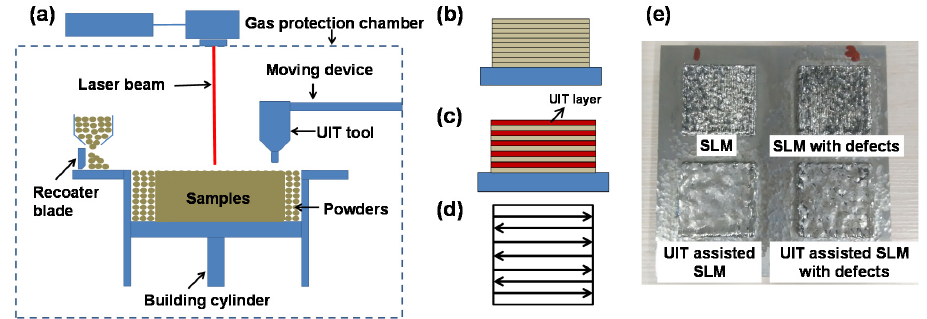
Figure 2. Schematic view of ( a ) UIT assisted selective laser melting (SLM); ( b ) SLM sample and ( c ) UIT assisted SLM sample; ( d ) scanning path of UIT; ( e ) four samples in this study.